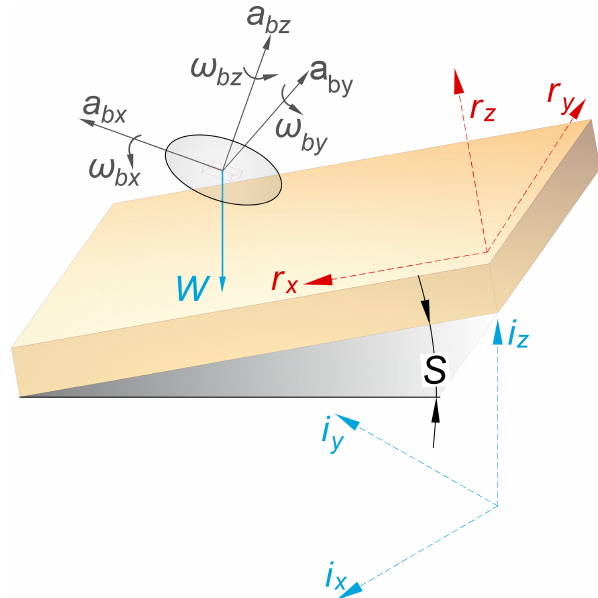
Figure A1. Frames of reference. r stands for riverbed (flume in this case) reference frame, b for body frame and i for the inertial reference